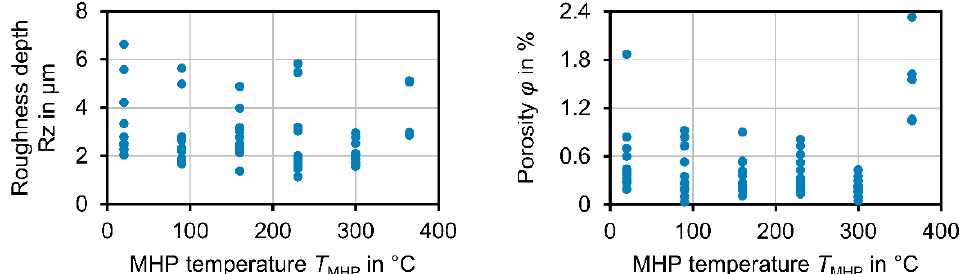
Figure 11. Roughness depth and porosity measured for ZnAl4 coatings thermally sprayed with dif- ferent process parameter settings after MHP treatment at temperatures between T MHP = 20 °C and T MHP = 365 °C.